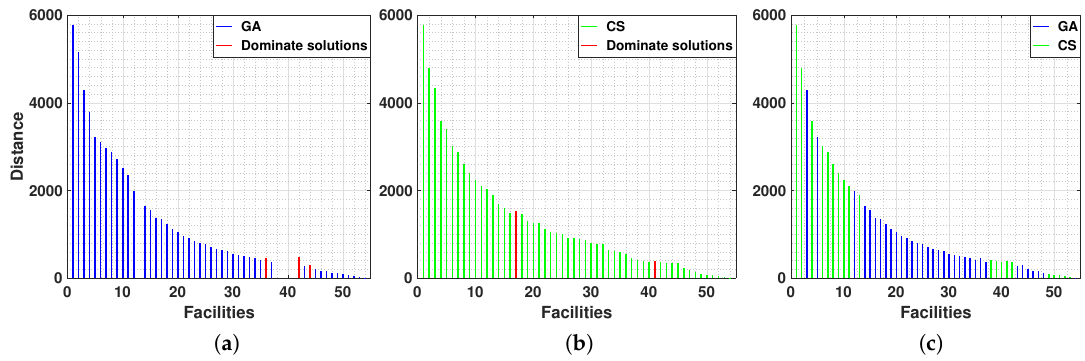
Figure 8. The Pareto set after solving the facility location problem for the Swain dataset using: genetic algorithms ( a ), crowdsourcing ( b ) and finally the genetic algorithm complemented by crowdsourcing solutions ( c ).